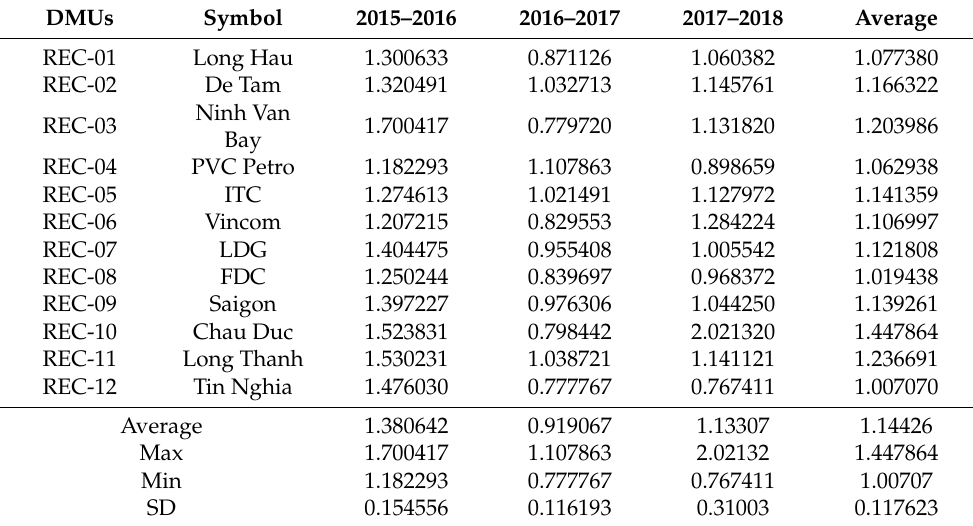
Table 8. Frontier-shift